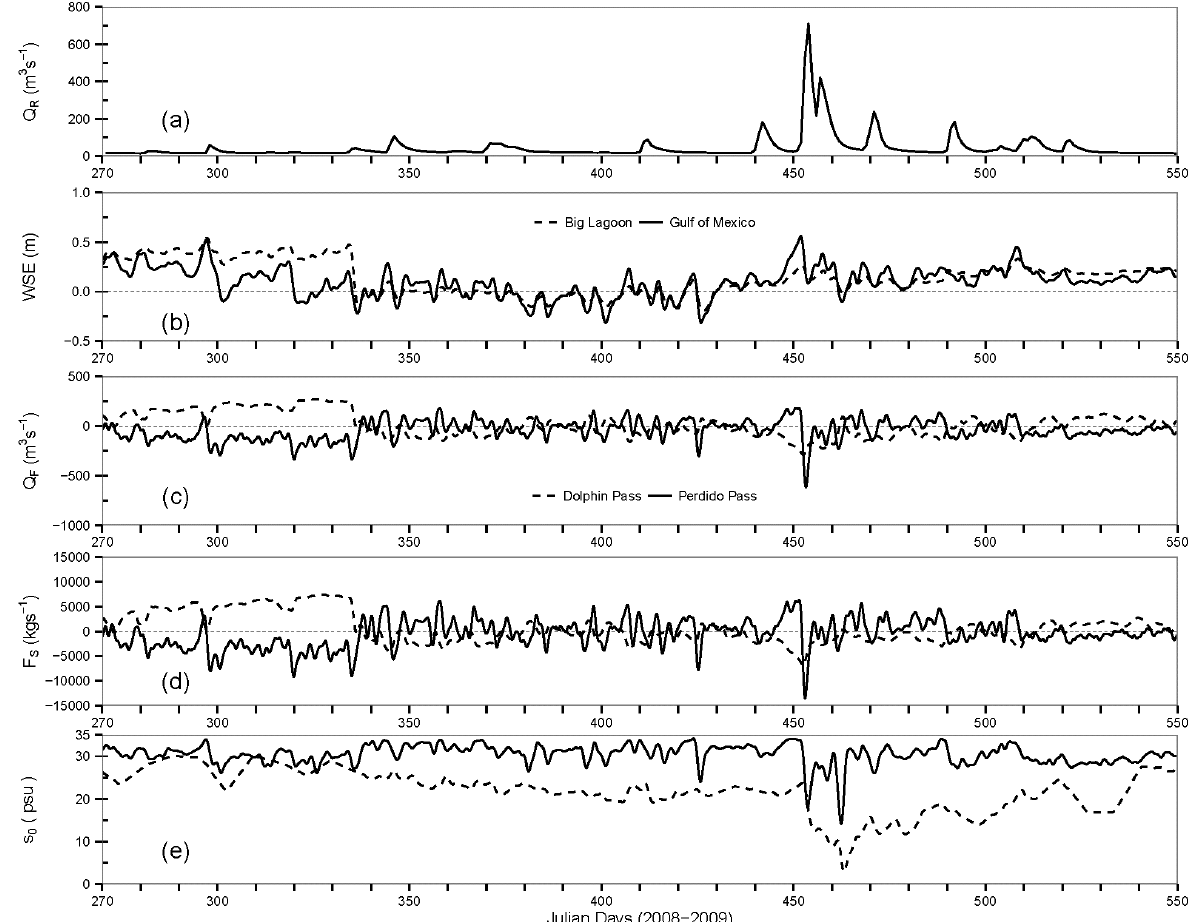
Figure 4. Time series of ( a ) discharge Q R (m 3 ·s − 1 ) from Perdido River and Styx River; ( b ) water surface elevation (WSE, m) at the Gulf of Mexico (solid line) and Big Lagoon (dashed line); ( c ) volumetric flow rate Q F (m 3 ·s − 1 ); ( d ) salt transport rate F S (kg·s − 1 ); and ( e ) cross-sectional average salinity s 0 (psu) at Perdido Pass and Dolphin Pass. Positive and negative fluxes in (c) and (d) indicate flow into and out of the Perdido